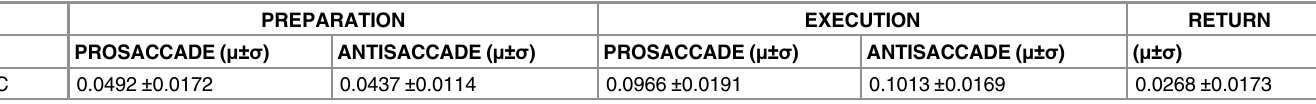
Table 6. Mean and standard error of normalised signal change for each saccade event